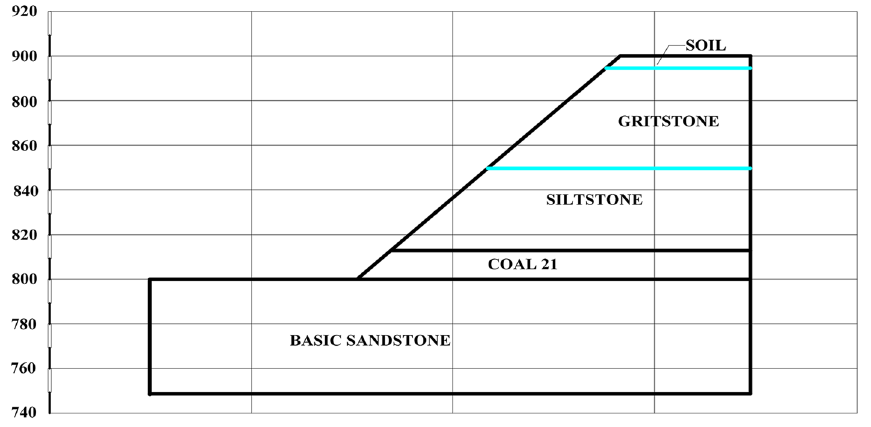
Figure 1. Schematic diagram of the lithology distribution for each stratum of the slope.